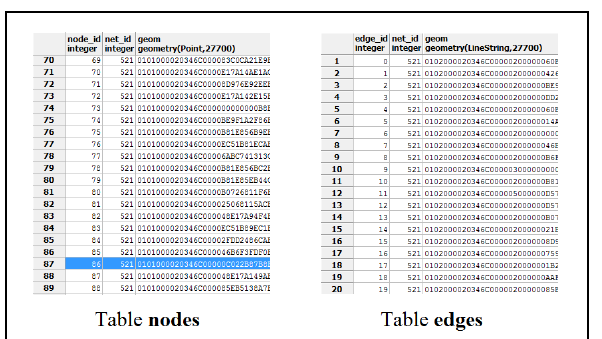
Figure 9. The table nodes and edges in PostGIS used to store node and edge geometries for the network shown in figure 8. Note the highlighted record in the nodes table corresponds to the Neo4j node in red rectangle in figure 8 ( node_id is 86).